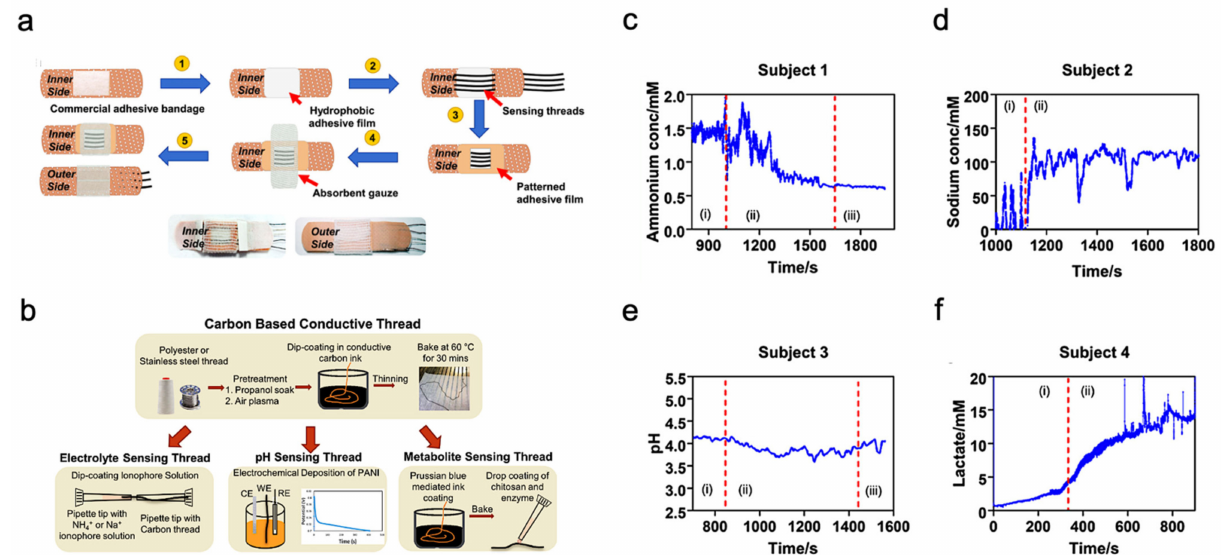
Figure 6. Sweat-based multimodal sensor patch for exercise monitoring. ( a ) Step-by-step process of fabrication and complete sensor patch prototype. ( b ) Fabrication of specialized sensing threads. ( c – f ) Measurement results of different biomarkers. Reproduced with permission from ref. [116], Copyright from 2020, Nature Publishing